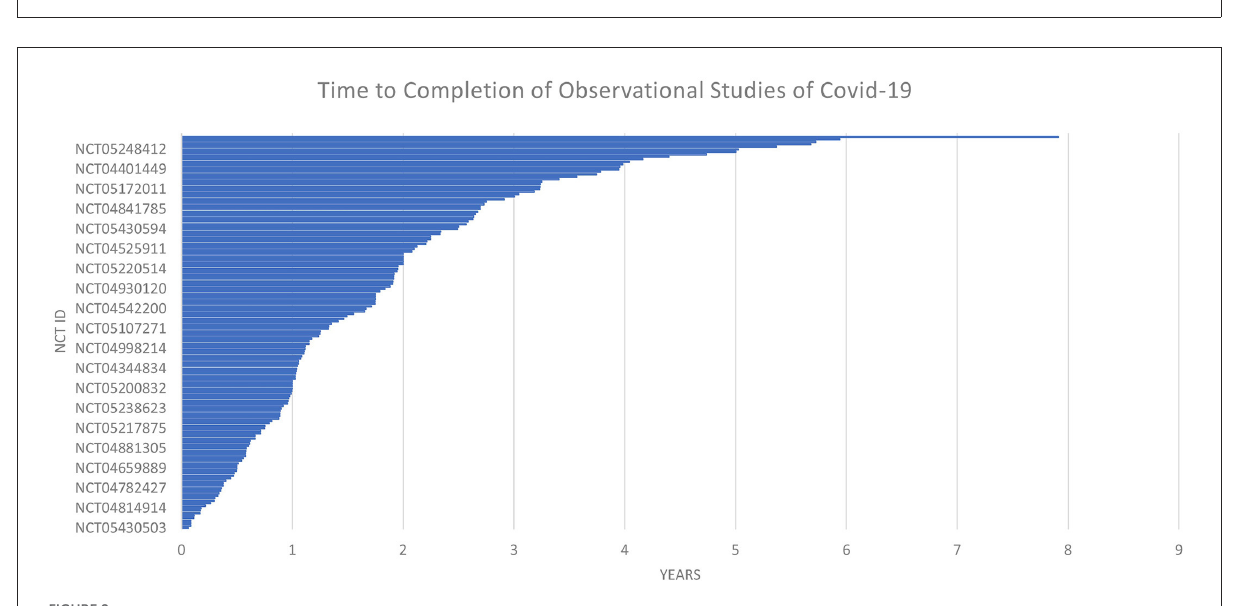
FIGURE8 Time to completion of observational studies of